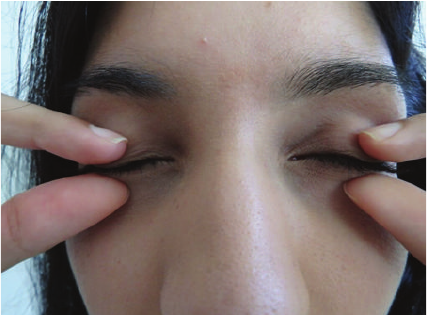
Figure 2: Massage (Part A of PBMP) of the lids. (i) Each patient is asked to close his or her lids under comfortably hot shower water and to massage, gently, both upper lids downwards and both lower lids upwards during those 30 seconds. This is done from a medial to lateral direction. (ii) The patient uses the thumb and index finger of the ipsilateral hand aiming to express the tarsal gland contents towards the lid